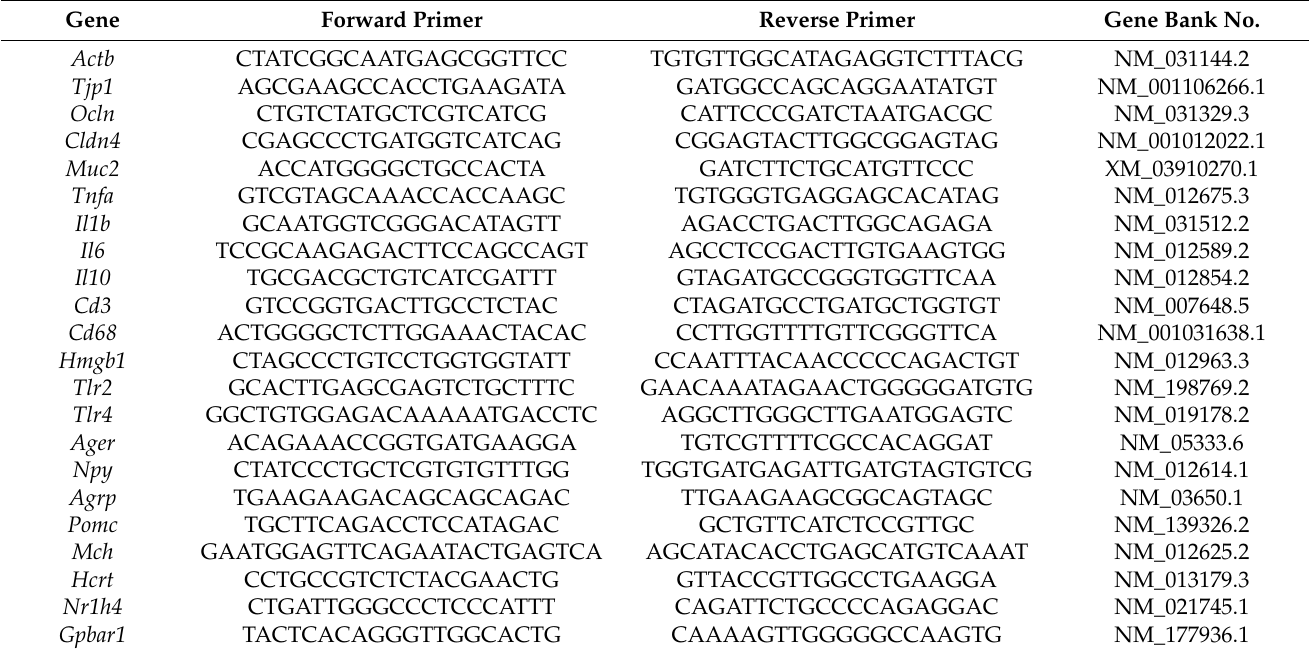
Table 1. Primers used in the quantitative real-time